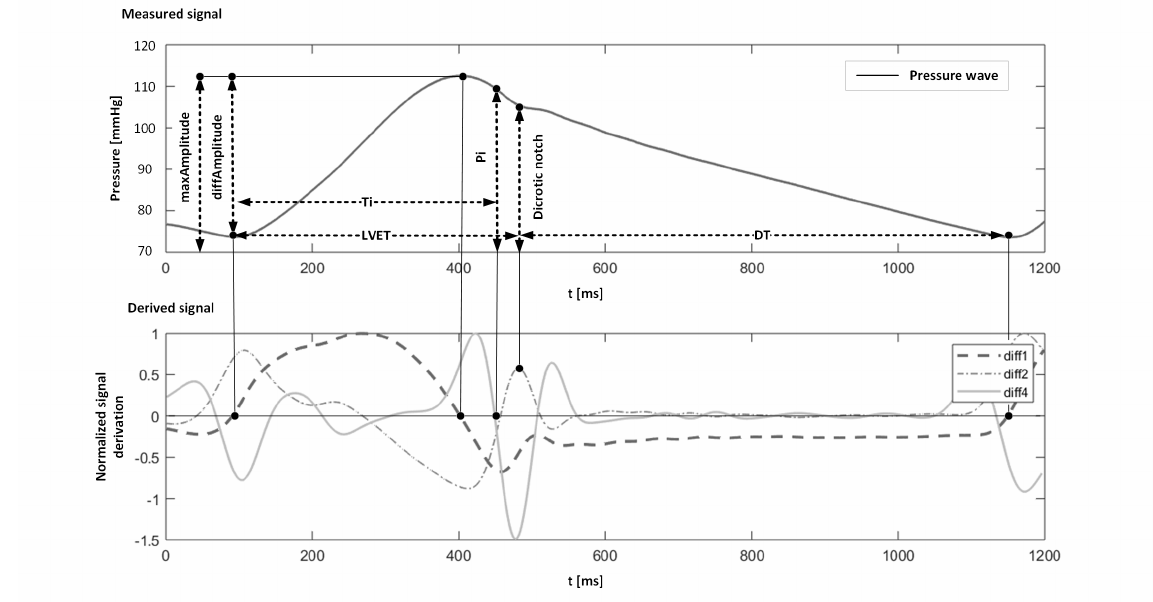
Figure 4. Pulse wave recorded on a patient-specific aorta (upper graph) and its first (diff1, Dashed line), second (diff2, Dash-dotted line) and fourth (diff4, Solid line) derivatives (lower graph) demonstrate how we measured the characteristic time parameters of the pulse wave (Ti, LVET, and DT) used for further